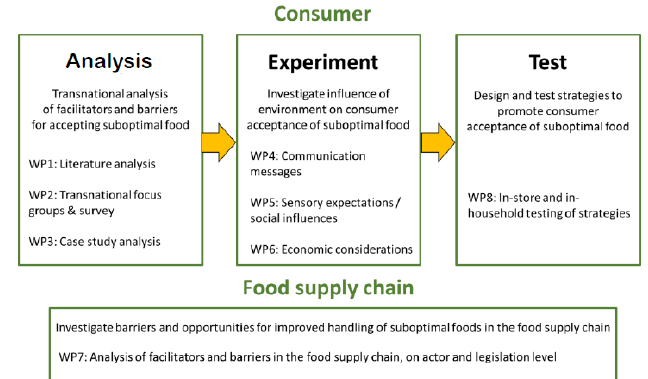
Figure 1. Outline of the Consumers in a sustainable food supply chain (COSUS) project. WP, workpackage conducted in the